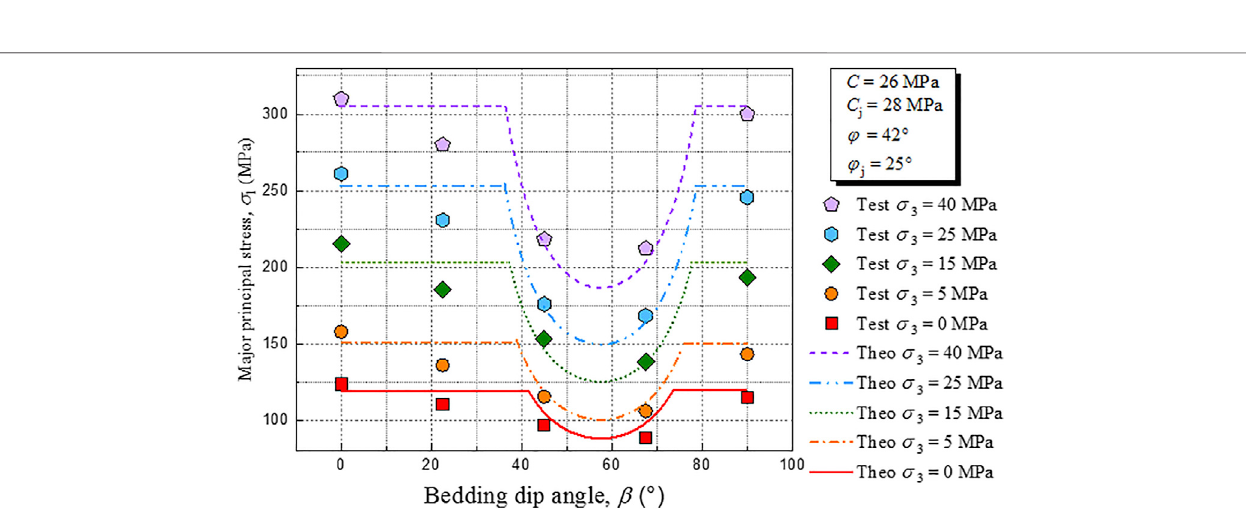
FIGURE 9 | Predicted strength curves of the JPW model and experimental